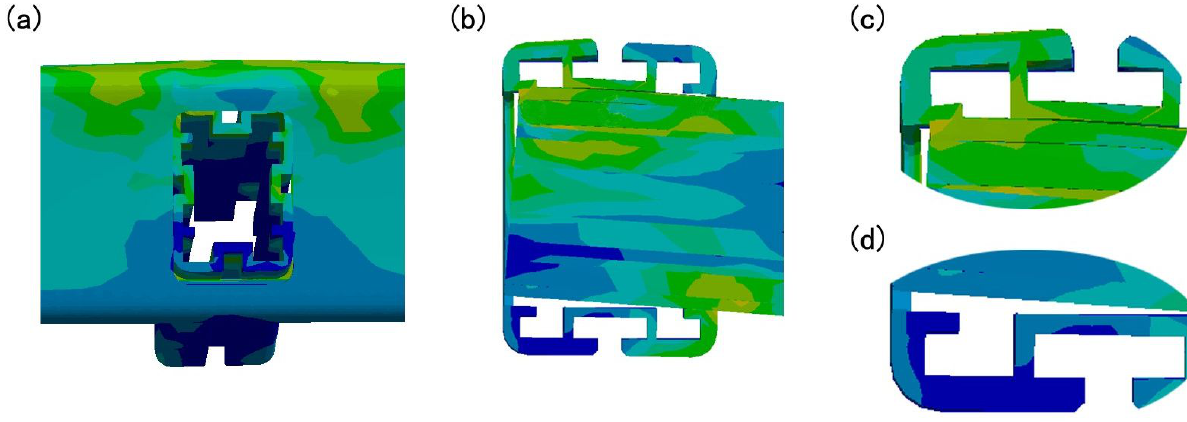
Figure 12: MT-T joints simulation deformation detail diagram